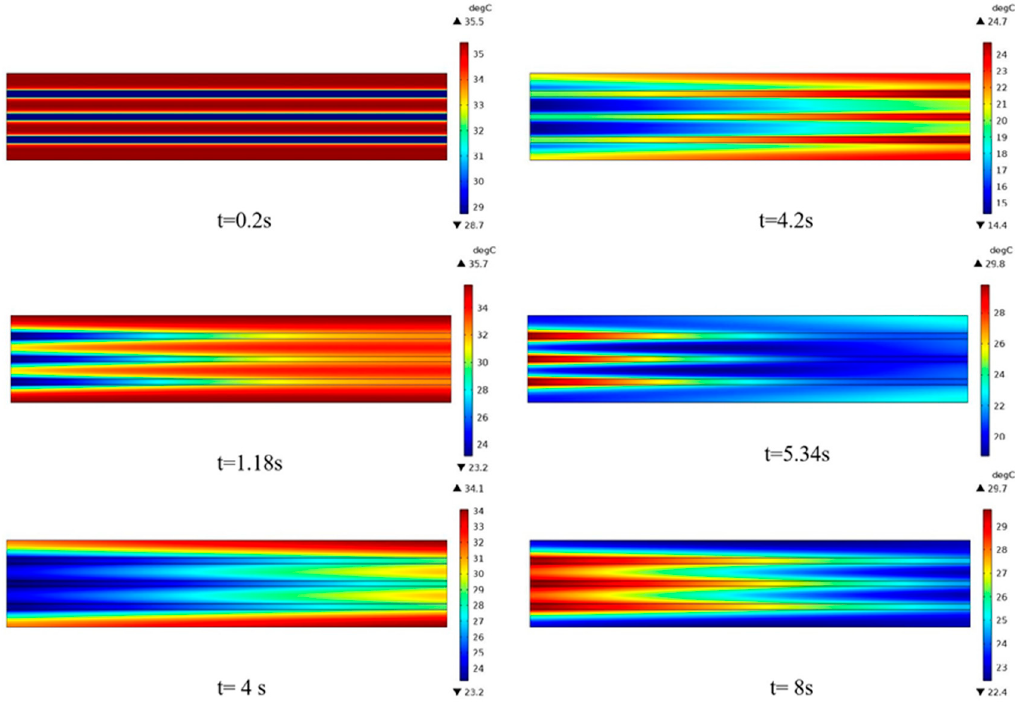
Figure 11. Temperature contour of the EC heat pump at Case 1.